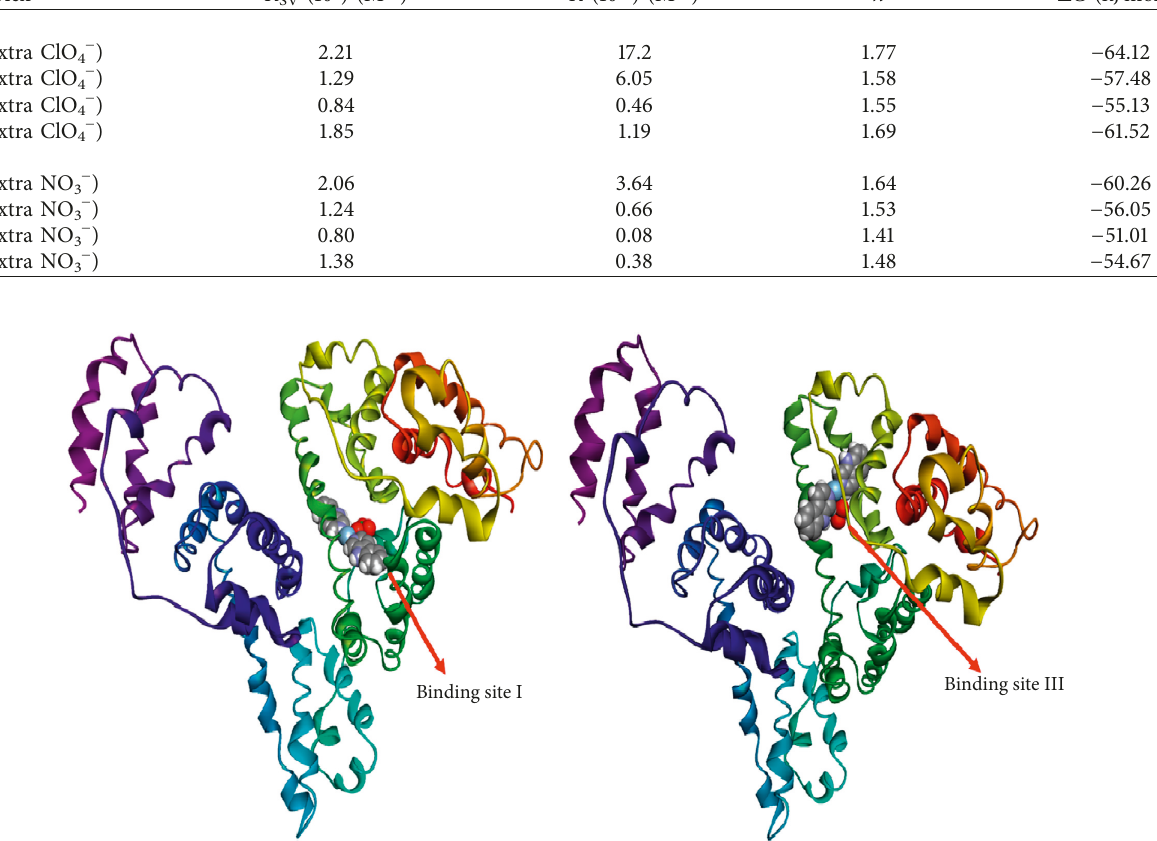
Table 2: Parameters for the interaction of HSA with Ag(I) compounds with the addition of extra anion, namely, ClO Complex